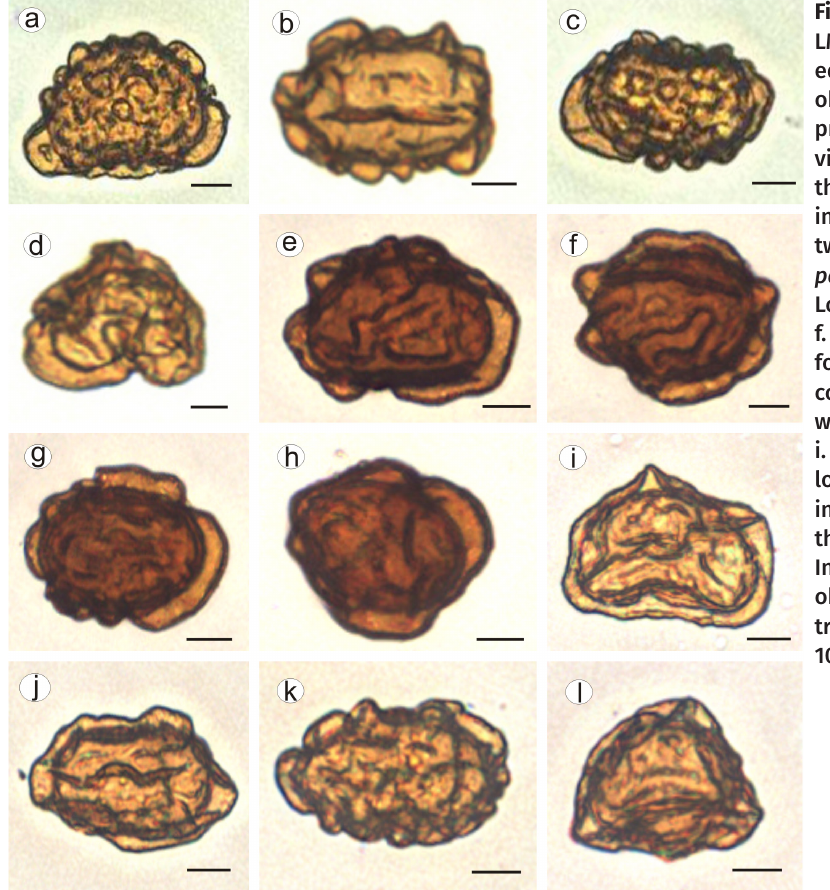
Figure 1. Spores of Dryopteris with LM. a-d: D. filix-mas. a. Spore in equatorial view. Large folds are observed at the edges. b. Spore in proximal view. c. Spore in distal view. Large folds are observed at the edges and subglobose folds in the center. d. Collapsed spore, twisted, with big folds. e-h: D. patula. e. Spore in equatorial view. Long folds in the edges are evident. f. Spore in proximal view with wide folds. g. Spore in distal view with coarse folds. h. Globose spore with large folds. i-l: D. wallichiana. i. Spore in equatorial view with long and branched folds. j. Spore in proximal view with long folds in the edges. k. Spore in distal view. Inflated, subglobose folds are observed. l. Abnormal spore with triangular shape. Scale bars: a-l = 10